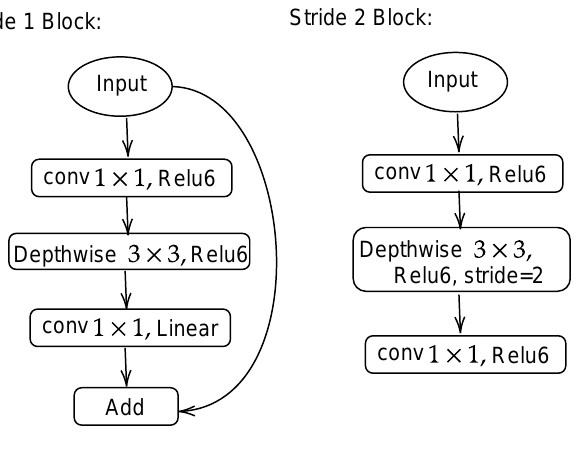
Figure 5. Blocks used in